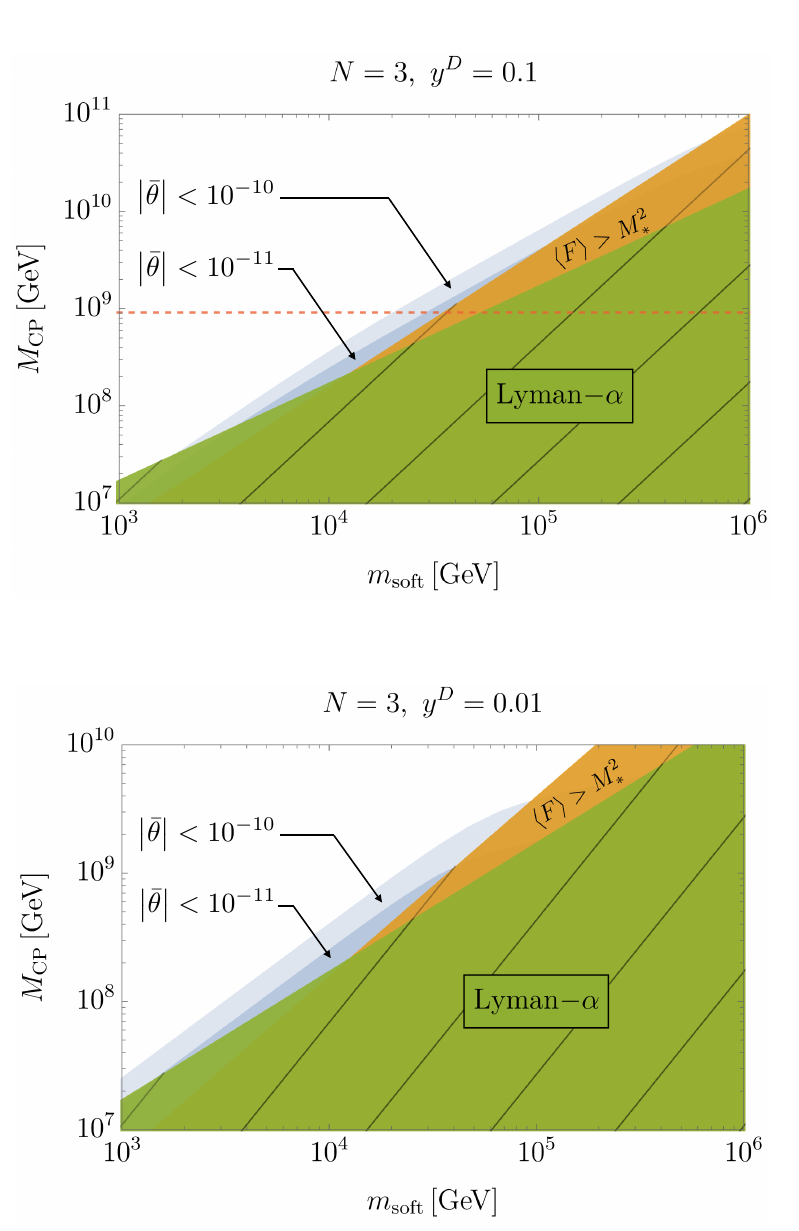
Figure 5 . Same as figure 4 but with the observed baryon asymmetry on the ( m soft , M CP ) -plane for y D = 0 . 1 (upper panel) and y D = 0 . 01 (lower panel) with N = 3 . The meshed green- and brown-colored regions are excluded because of the Lyman- α constraint and by the condition of h F i < M 2 , respectively. The red dashed line in the upper panel represents the most conservative ∗ lower bound on M CP from the domain wall formation, which can be relaxed for a small value of H inf